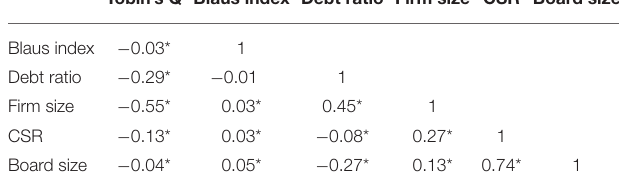
TABLE 7 | Hypotheses assessment